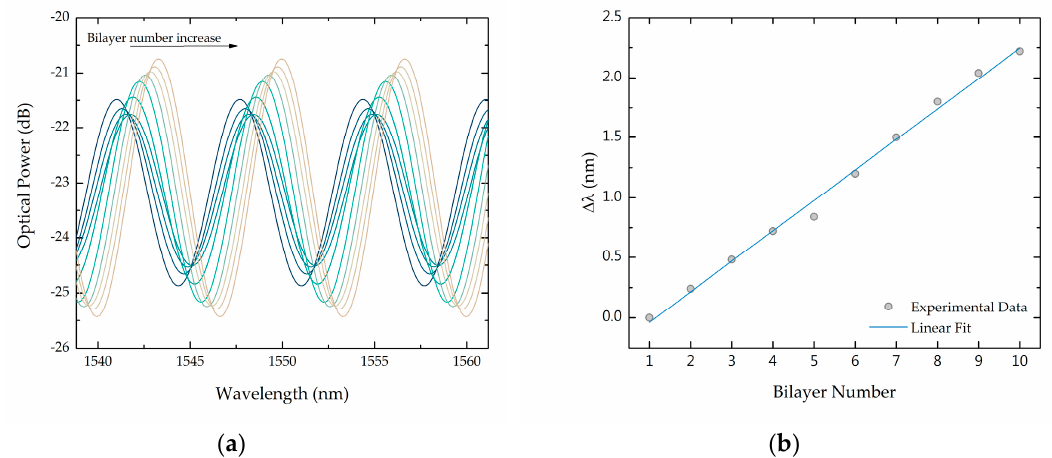
Figure 6. ( a ) Filtered signal corresponding to peak 2; ( b ) Wavelength shift of the peaks.